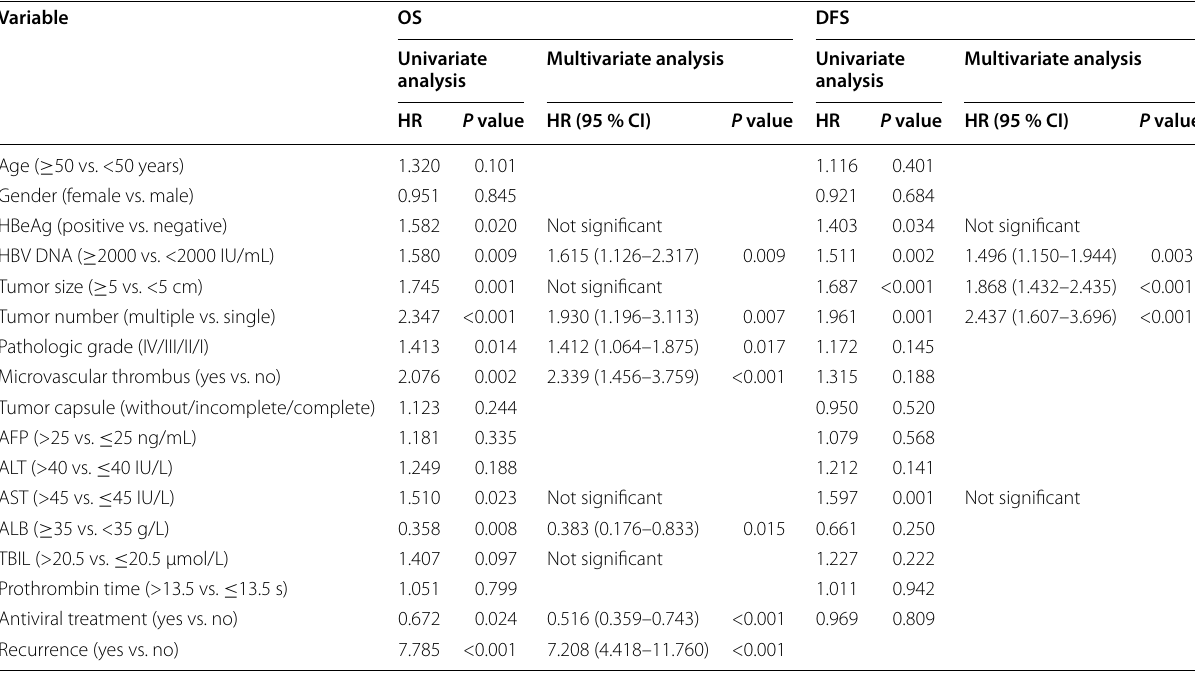
Table 2 Relationship between clinical characteristics and overall survival (OS)/disease-free survival (DFS), as determined by univariate and multivariate Cox regression